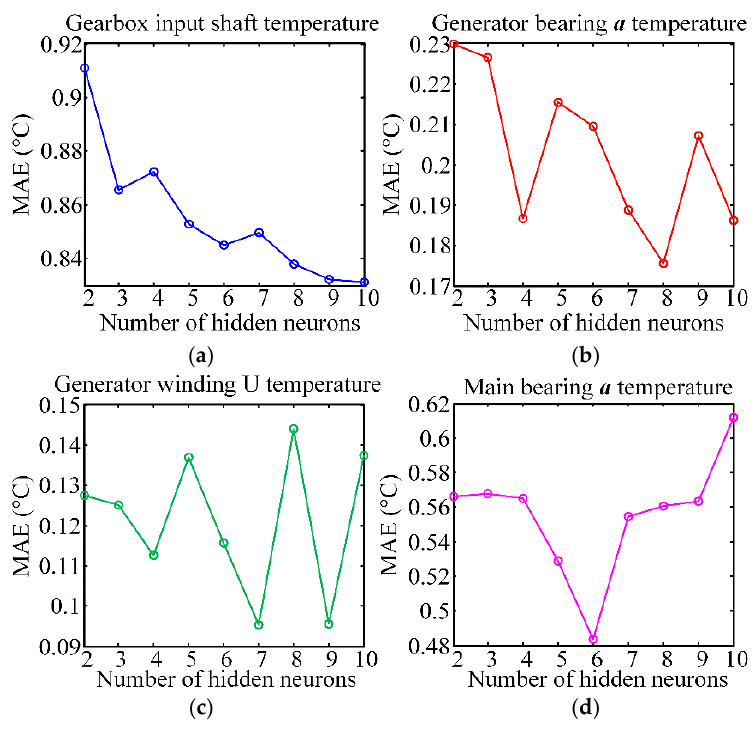
Figure 6. The back ‐ propagation neural network (BPNN) performances over the numbers of hidden nodes. ( a ) Gearbox input shaft temperature; ( b ) Generator bearing a temperature; ( c ) Generator winding U temperature; and ( d ) Main bearing a temperature.